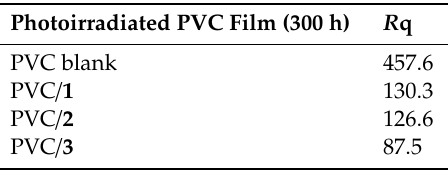
Table 5. Roughness factor ( R q) for PVC after irradiation.